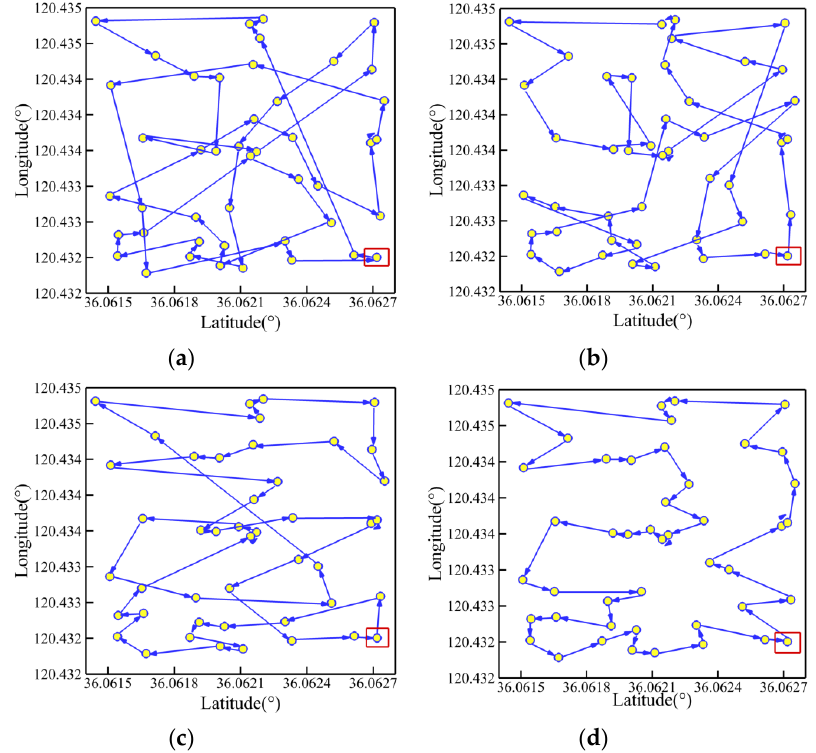
Figure 9. Trajectory planned by each algorithm for Q = 45: ( a ) CPSO; ( b ) APSO; ( c ) AWPSO; ( d ) AWIPSO.